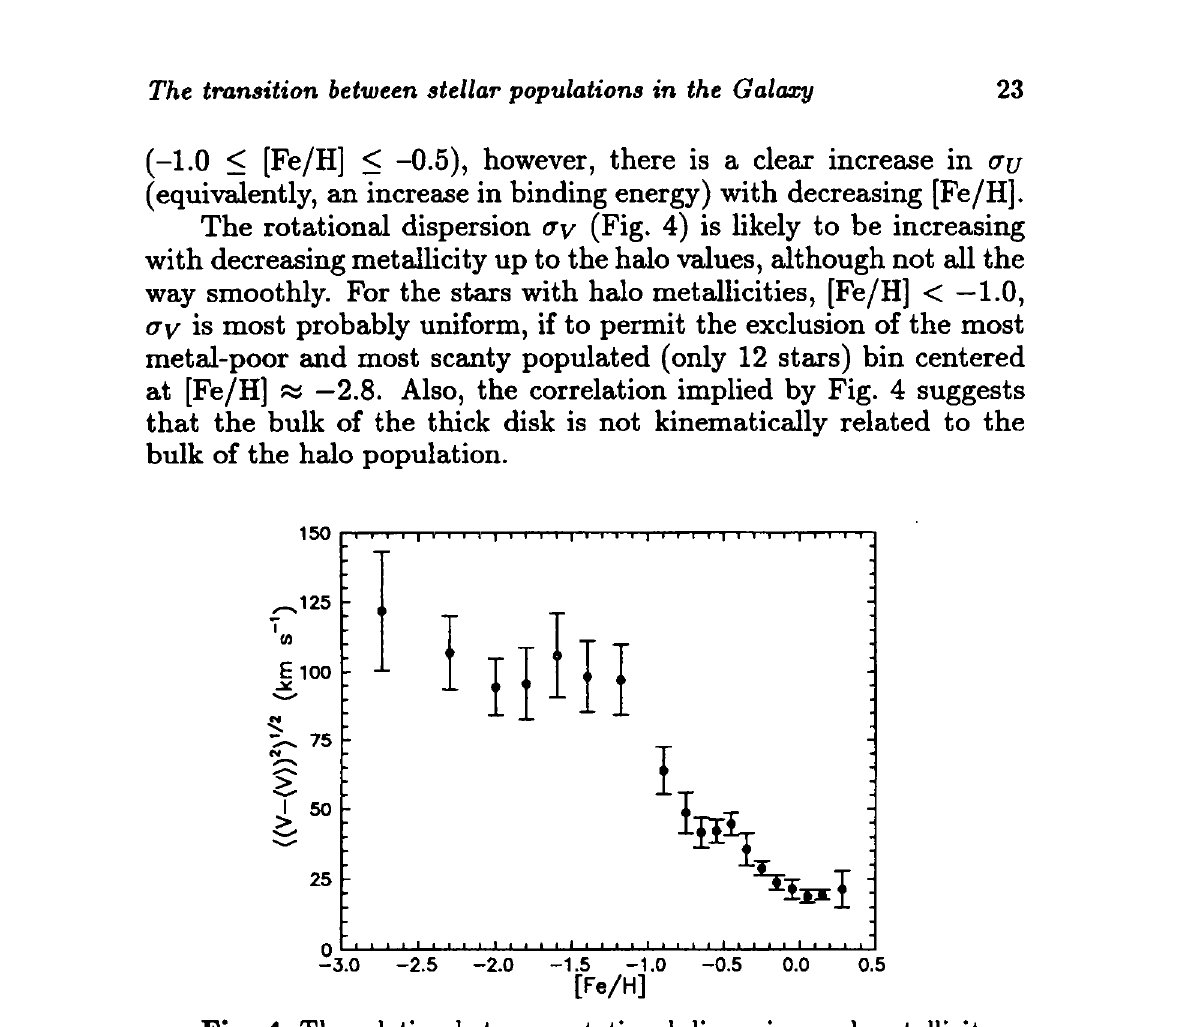
Fig. 4. The relation between rotational dispersion and